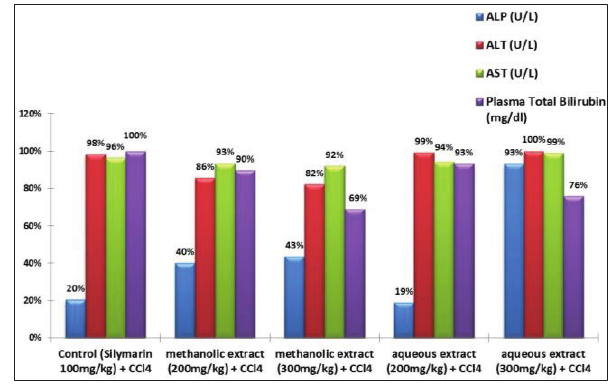
Fig-2: Percentage protection of various biochemical parameters against CCl4-induced hepatic injury.